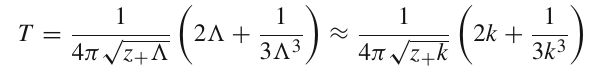
3 > a 2 > 1 / 3, the expression of temperature in (24) can